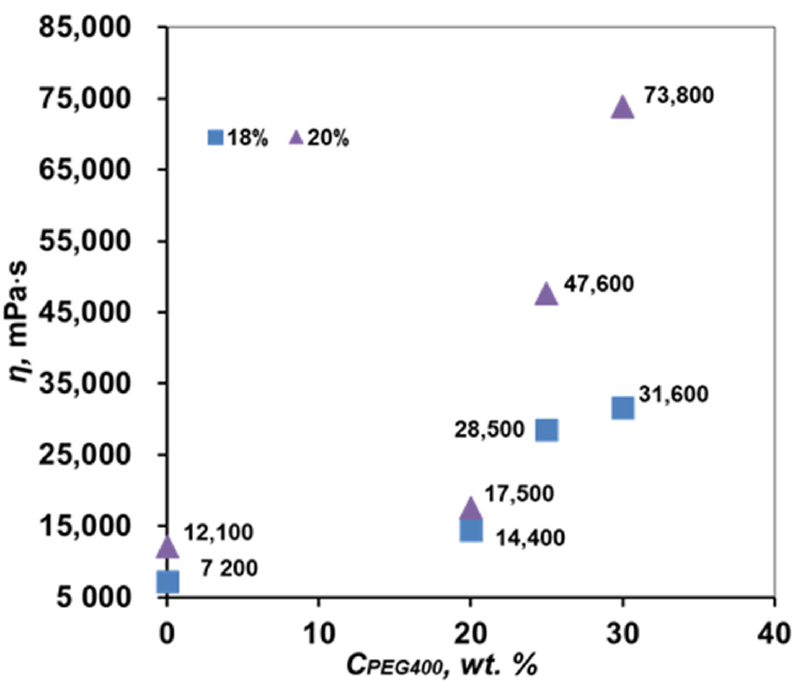
Figure 6. Dependence of the dynamic viscosity of the PPSU-5/NMP/PEG400 system on the PEG400 concentration at 22 °C.